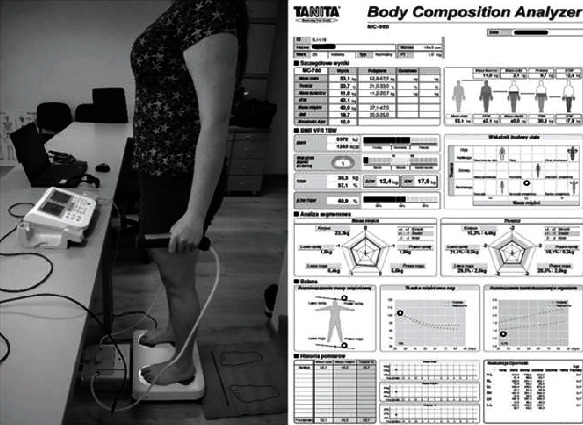
Participant during measurement with the use of the TANITA device.